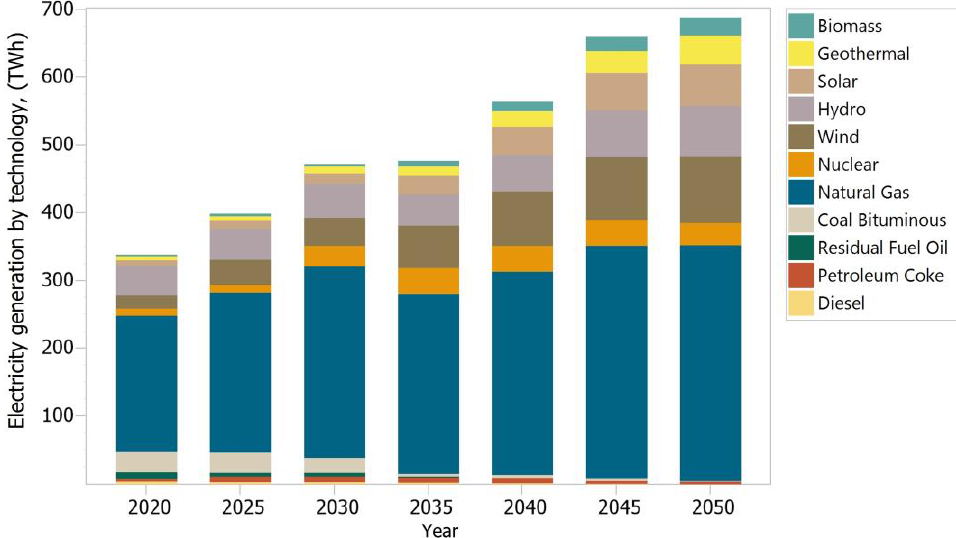
Figure 8. CVF-4.0 MWh scenario. Electricity generation by technology. Source: own elaboration with data from [7,29].